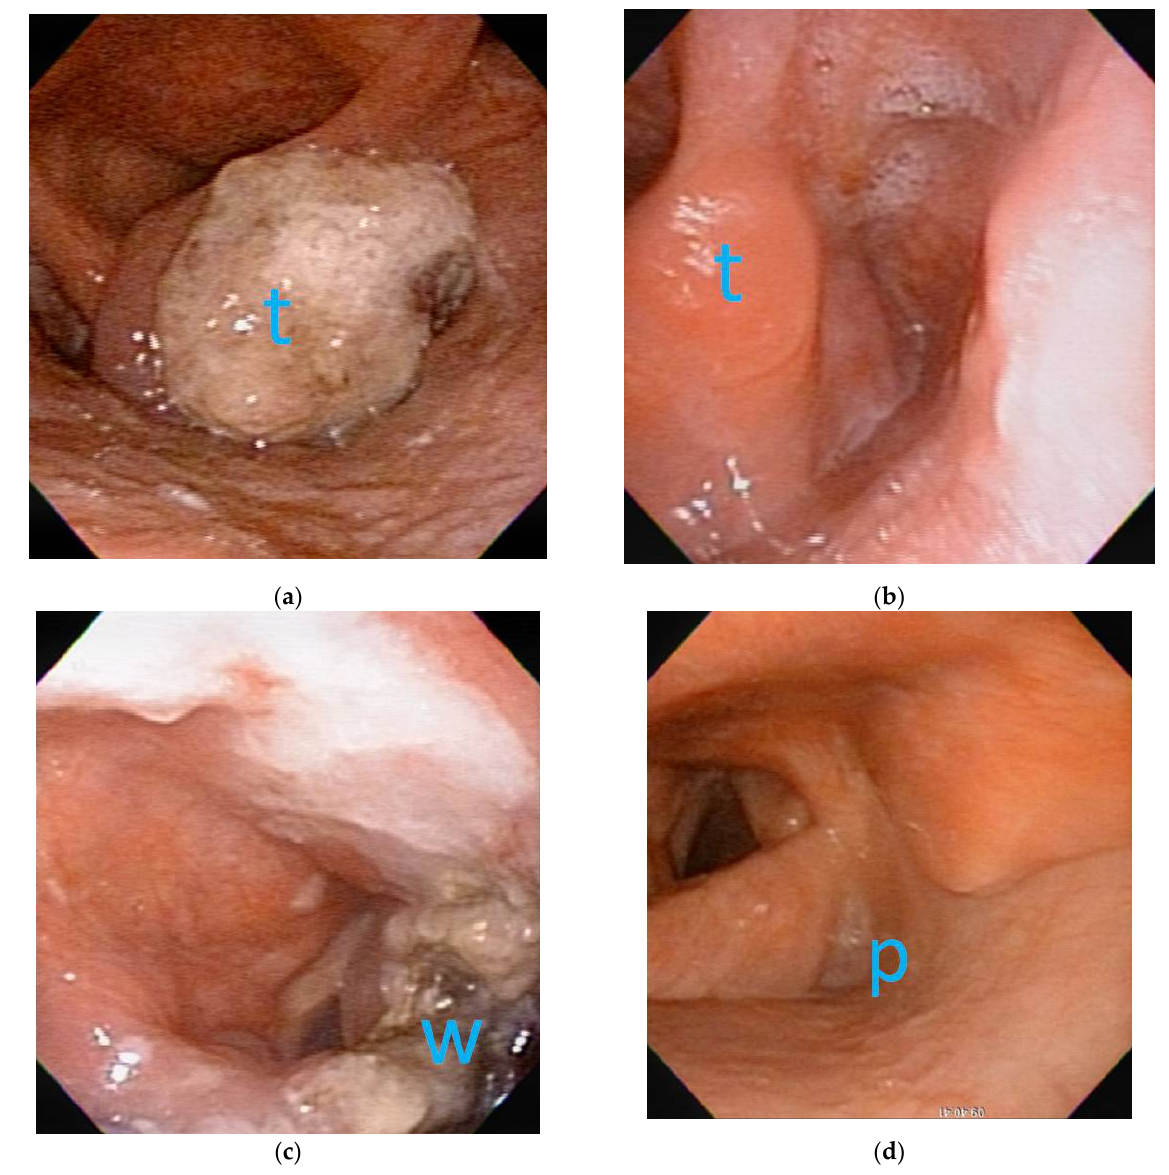
Figure 2. The flexible laryngoscopic images before and after neoadjuvant chemotherapy (NACT) and transoral robotic surgery (TORS):( a ) before NACT, a clinical T3 tumor (t) was located at right-side arytenoepiglottic fold with impaired right vocal fold motion; ( b ) after NACT, complete remission of tumor (t) was achieved with no obvious tumor seen on right-side arytenoepiglottic fold. ( c ) Three days after TORS, the wound coated with fibrin showed the excision extent in accordance with original tumor border. ( d ) Three years after TORS without adjuvant radiotherapy, the pyriform sinus (p) exhibited good appearance without tumor recurrence.